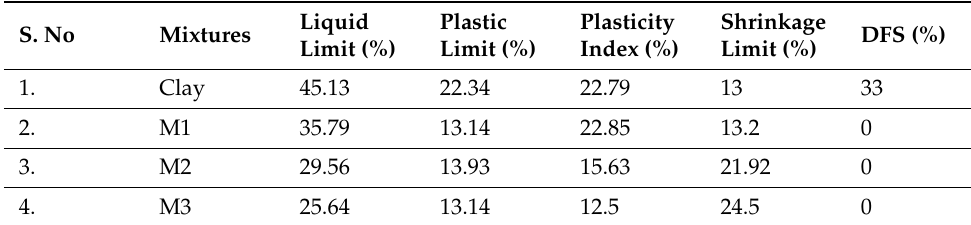
Table 4. Variation in Index properties of clay–GS